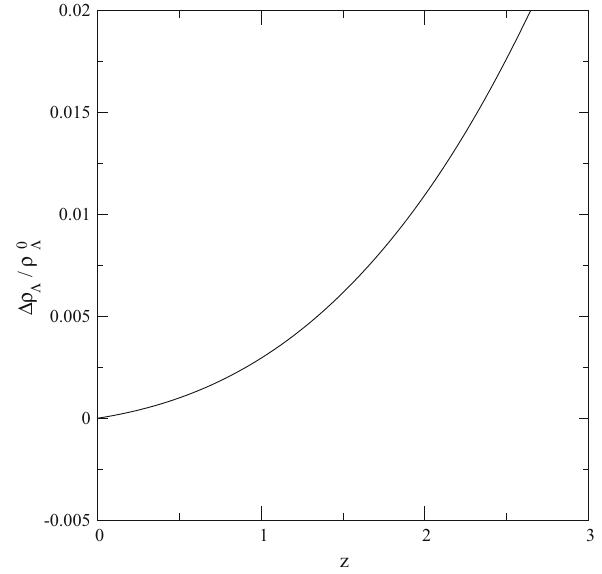
Fig. 7 The relative variation of ρ (cid:2) ( z ) (the vacuum energy density) with respect to the current value, within the RVM for ν = 0 . 001, as a function of the redshift – see Eq.